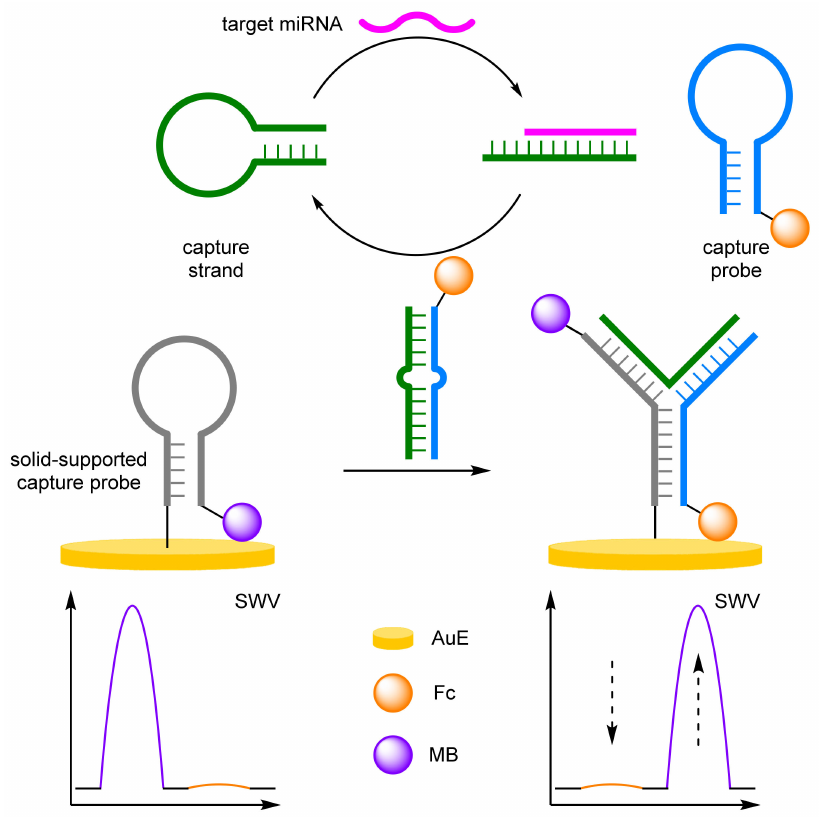
Figure 20. Schematic representation of catalytic hairpin assembly-based